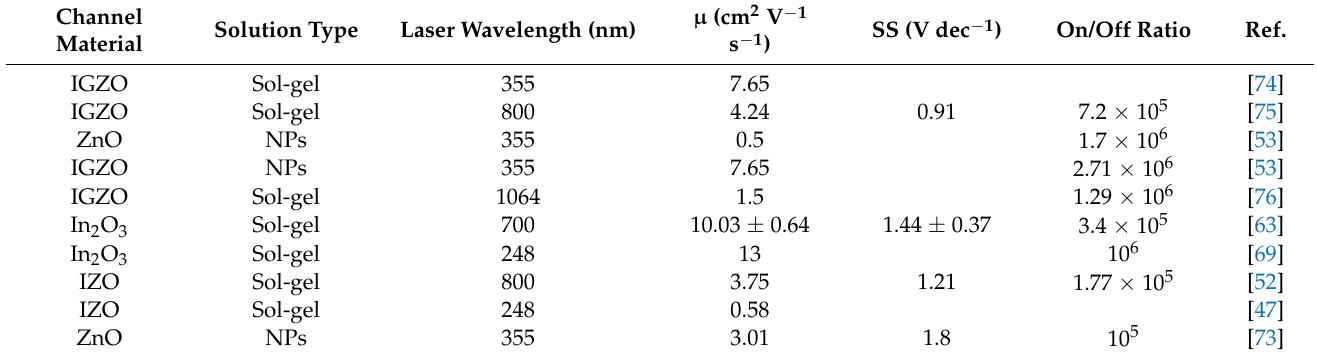
Table 2. Examples of laser treatment of MOS-TFT.